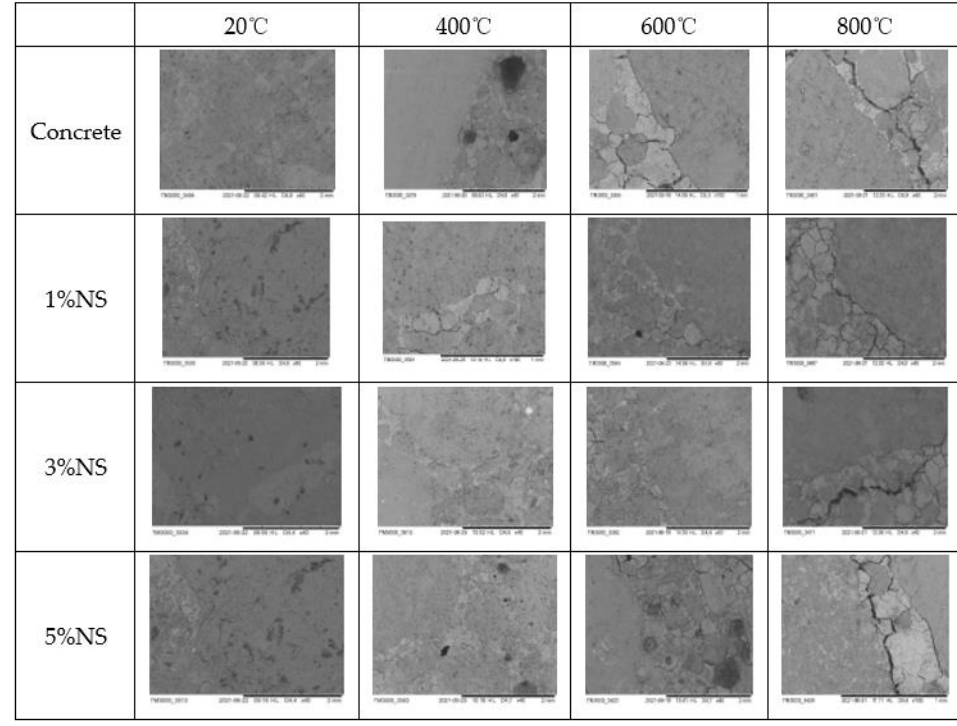
Figure 15. Appearance deformation of NS with different dosages after heating at 400 °C to 800 °C [121].